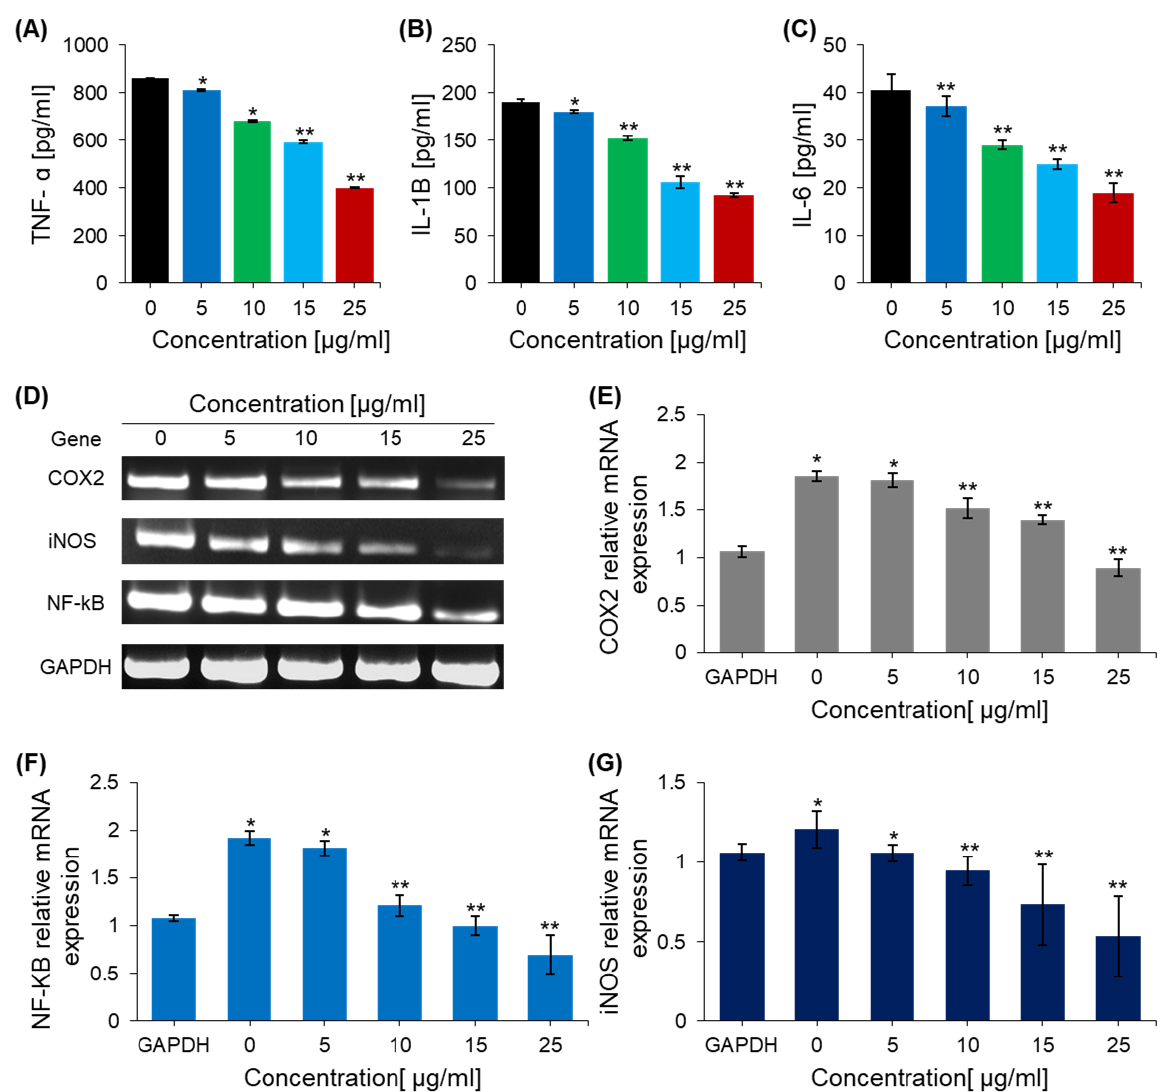
Figure 6. The anti-inflammatory effect of saponins. ( A ) Quantification of Tumor necrosis factor alpha (TNF- α ) in cells treated with various concentrations of saponins. ( B ) The effect of saponins on the release of the pro-inflammatory cytokine interleukin-1 β (IL-1 β ), quantified in control and treated cells with an ELISA. ( C ) The effect of saponins on the release of the proinflammatory cytokine IL-6, quantified in control and treated cells with an ELISA. ( D ) The DNA bands of inflammation-related genes from the RT-PCR. ( E ). The relative mRNA expression of the pro-inflammatory gene COX-2 in treated and control cells determined by RT-PCR. ( F ) The relative mRNA expression of the pro-inflammatory gene NF-kB in treated and control cells determined by RT-PCR. ( G ) The relative mRNA expression of the pro-inflammatory gene iNOS in treated and control cells determined by RT-PCR. * = p < 0.001, ** = p < 0.001 compared with the control.